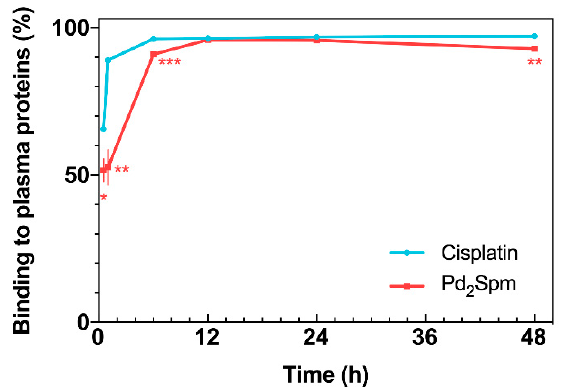
Figure 3. Drug binding to plasma proteins versus time, for cisplatin and Pd 2 Spm. Data are ex- pressed as mean ± SEM ( n = 5 animals per time point) and were compared with Student’s t -test. * p < 0.05, ** p < 0.01, *** p <